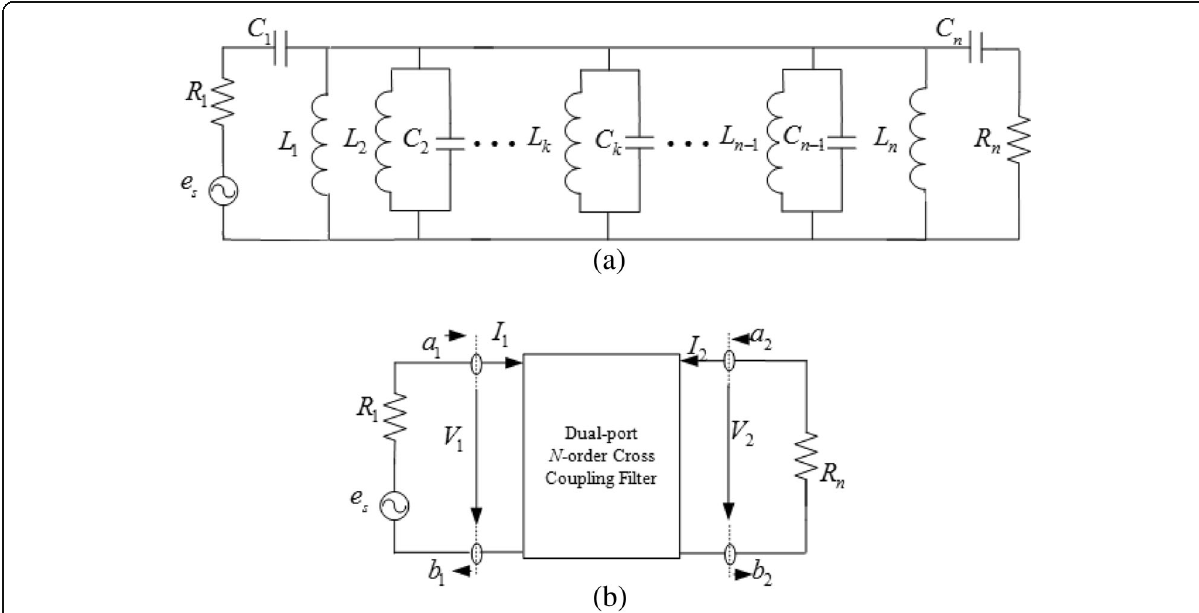
Fig. 2 Equivalent circuit ( a ) and equivalent network parameters ( b ) of the loop equation of lumped parameter of N -order coupling